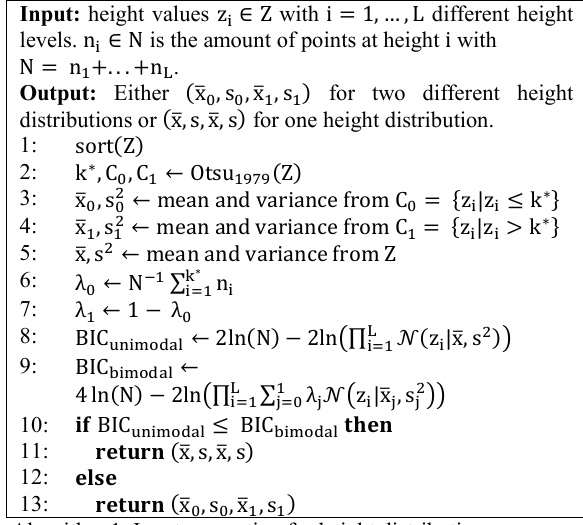
Algorithm 1 : Input generation for height